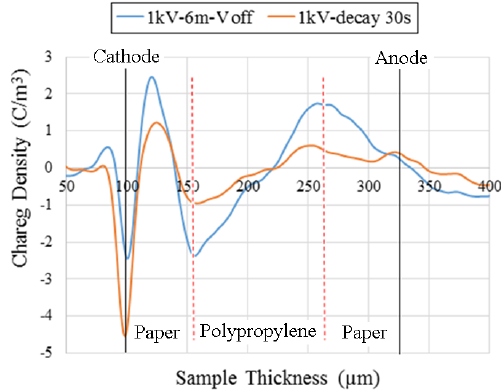
Figure 31. Space charge distribution in PPLP film under 1 kV applied voltage (volt ‐ off).